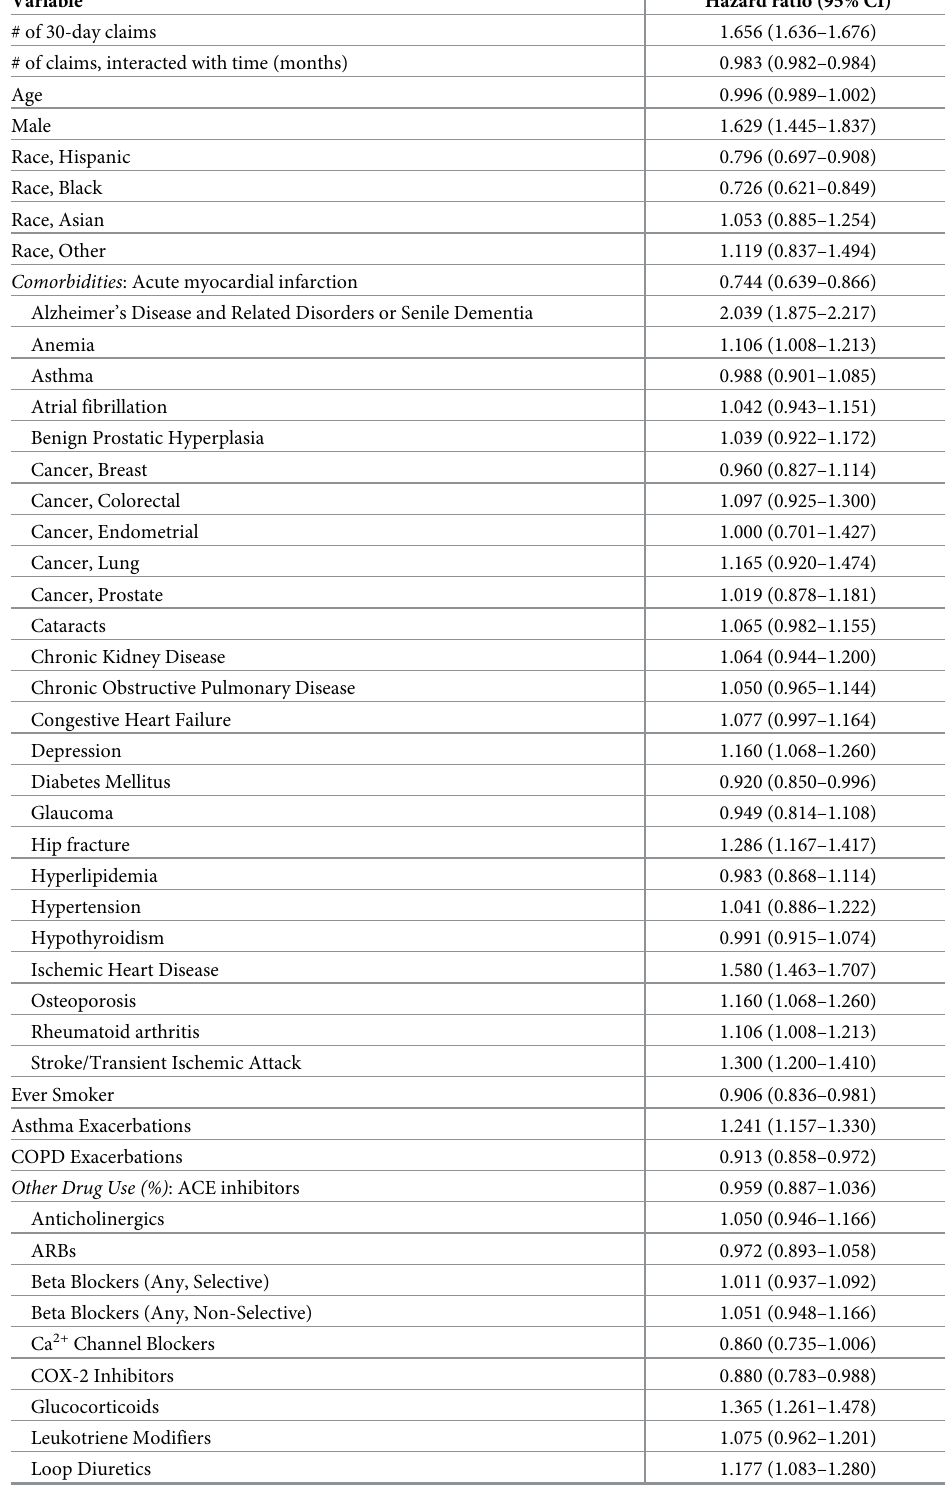
Table 4. Cox analysis of β 2-agonist use (30-day